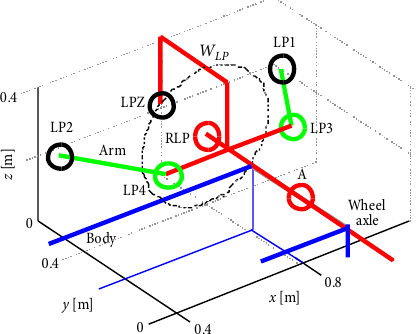
Fig. 7. Left anterior quarter of the vehicle model of real size